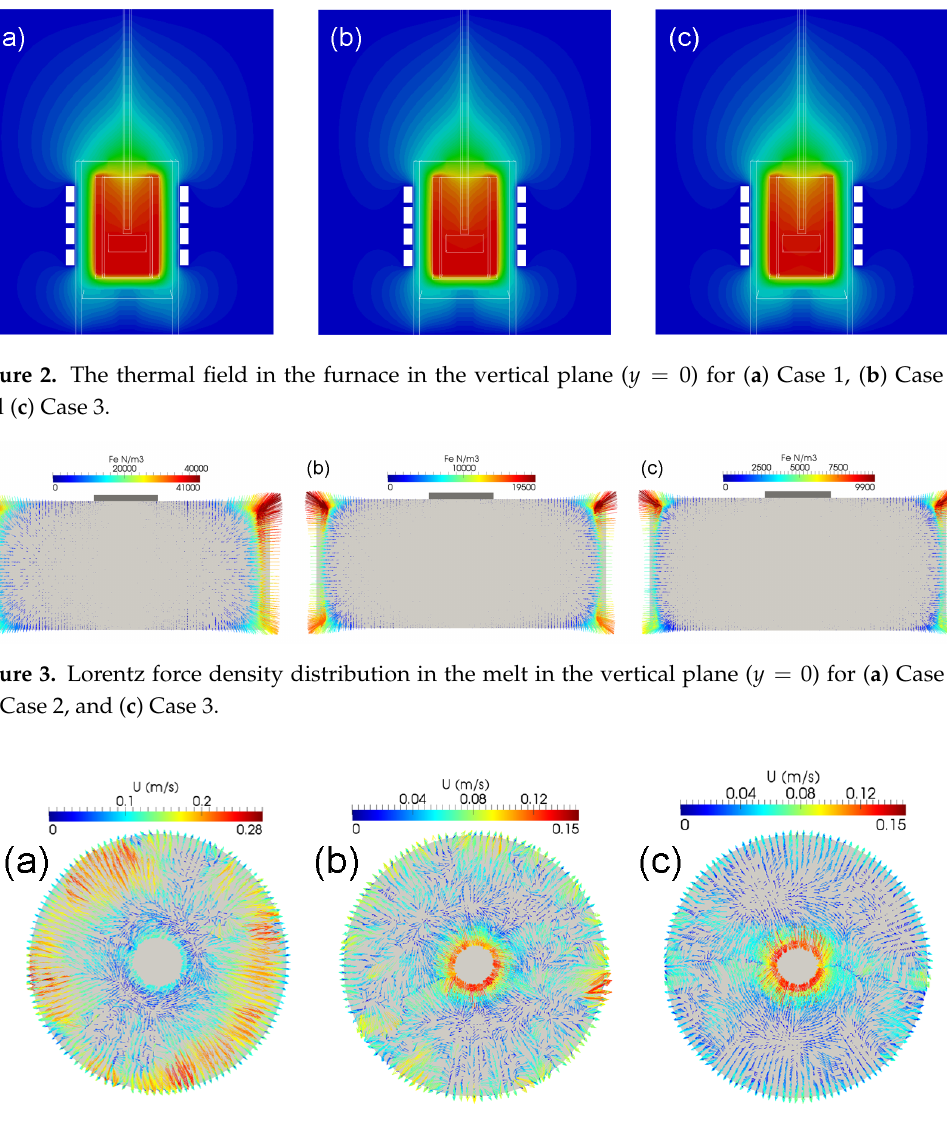
Figure 4. The instantaneous flow velocity vectors at the top horizontal plane of the melt for ( a ) Case 1, ( b ) Case 2, and ( c ) Case